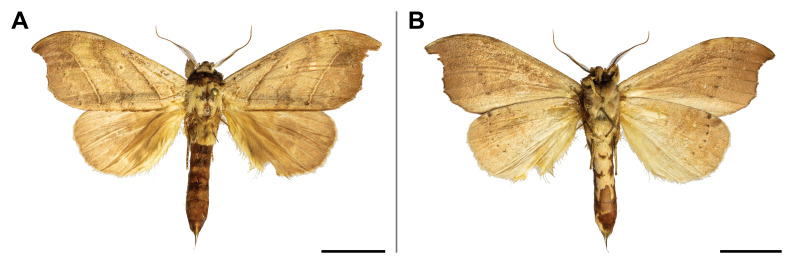
Pseudobarobata
denticulata Kiriakoff, 1966. A. dorsal view; B. ventral view. The scale bar represents 1 cm.